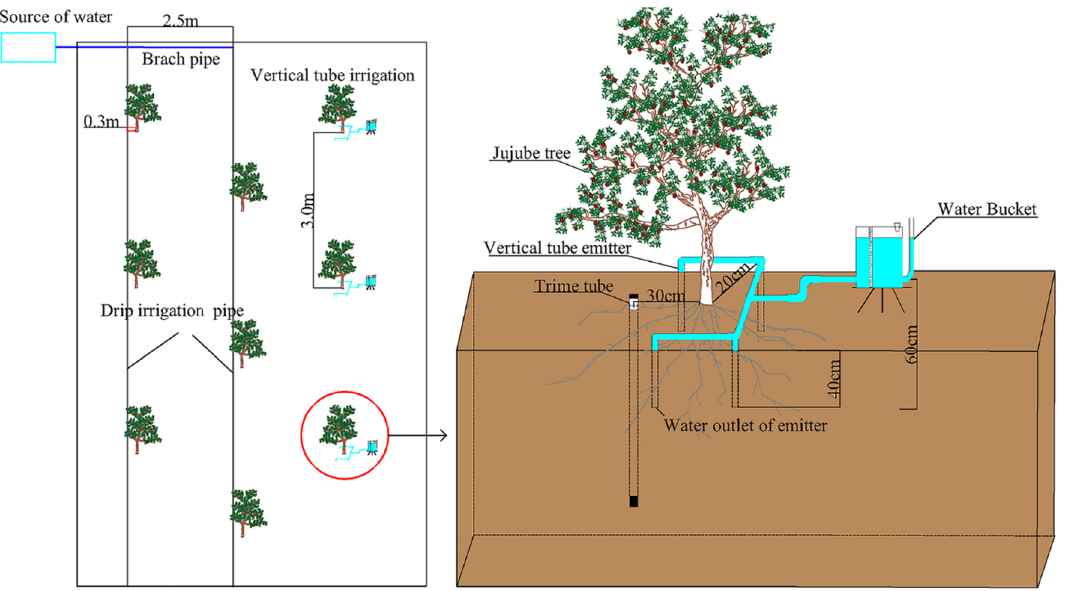
Figure 2. The field experiment setup for vertical tube irrigation and drip irrigation.